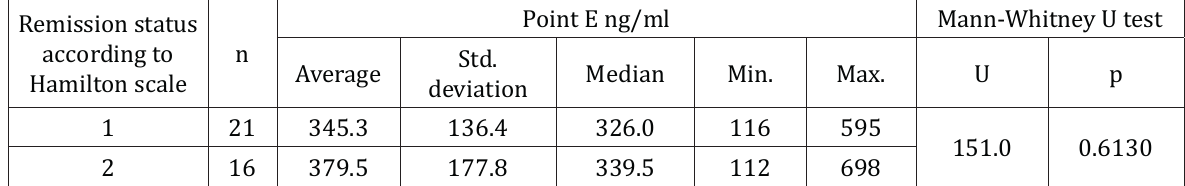
Table 19. Descriptive statistics – Concentration of MMP-9 at the end point of the study in patients in different states of remission according to the HDRS and the results of a Mann-Whitney U test.